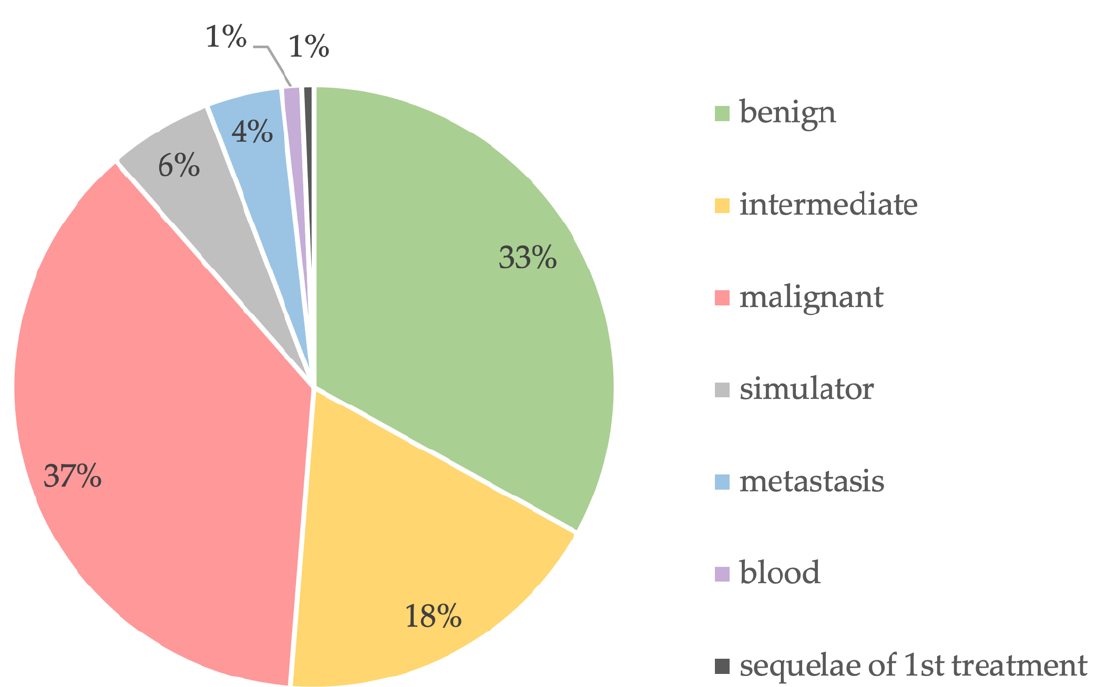
Figure 4. Biological diagnosis of the lesions.